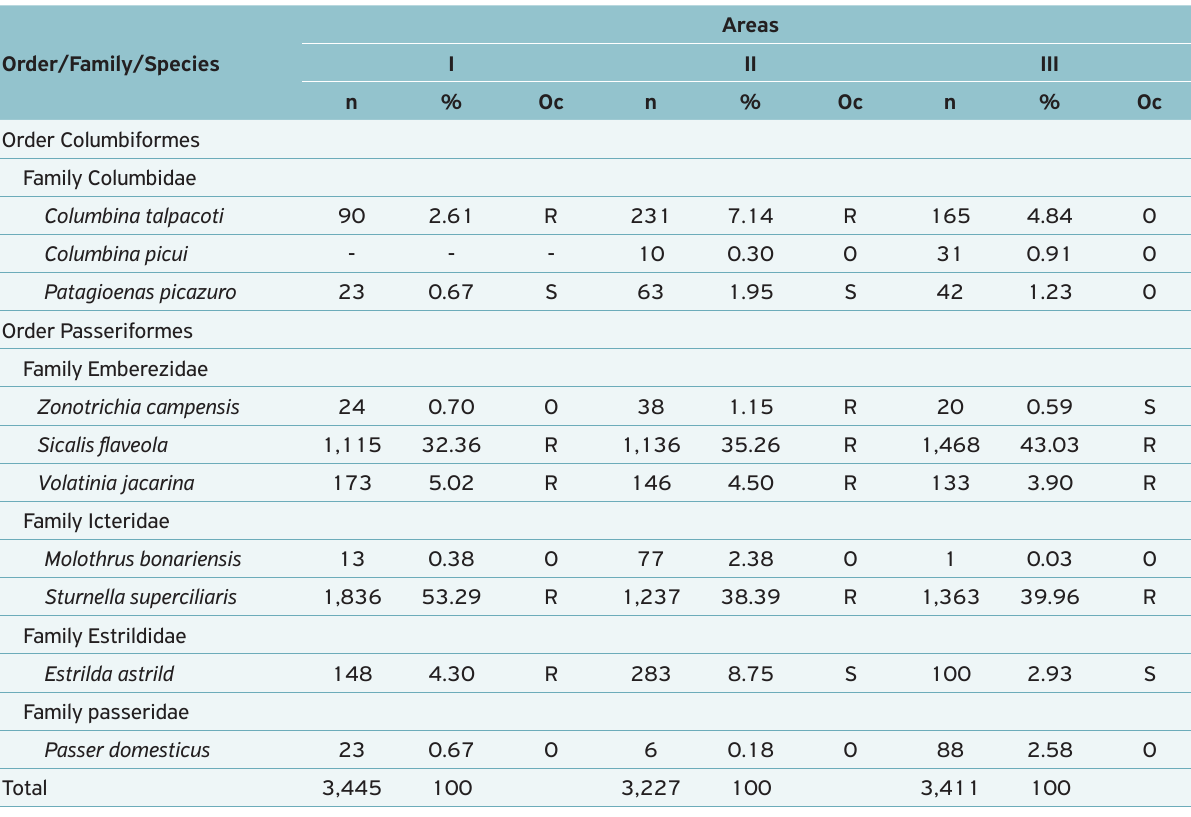
Table 1. Avifauna found in ricefields by percentage and occurrence.